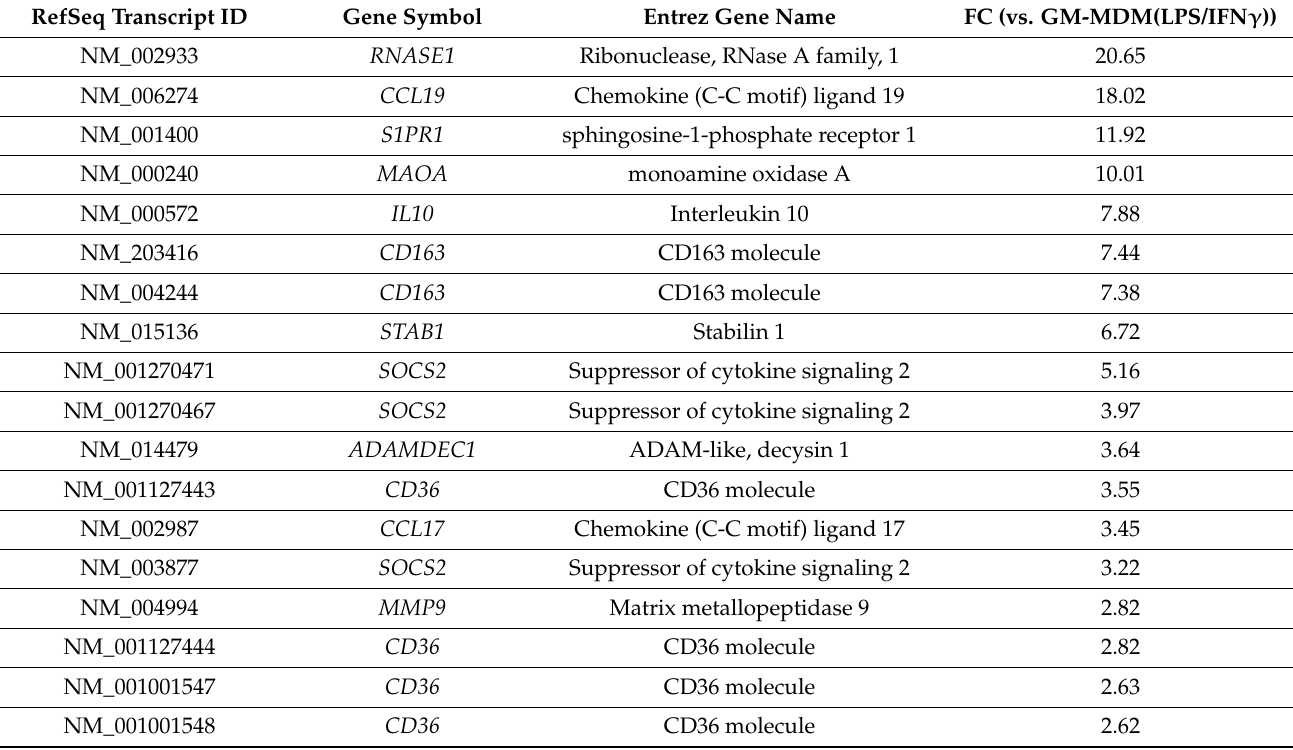
Table 1. Select transcripts significantly differentially expressed between lipopolysaccharide (LPS)/interferon γ (IFN γ )- activated human monocyte-derived macrophages (MDMs) that were differentiated with macrophage colony-stimulating factor (M-MDM(LPS/IFN γ )) and granulocyte/macrophage colony-stimulating factor (GM-MDM(LPS/IFN γ )). RefSeq Transcript